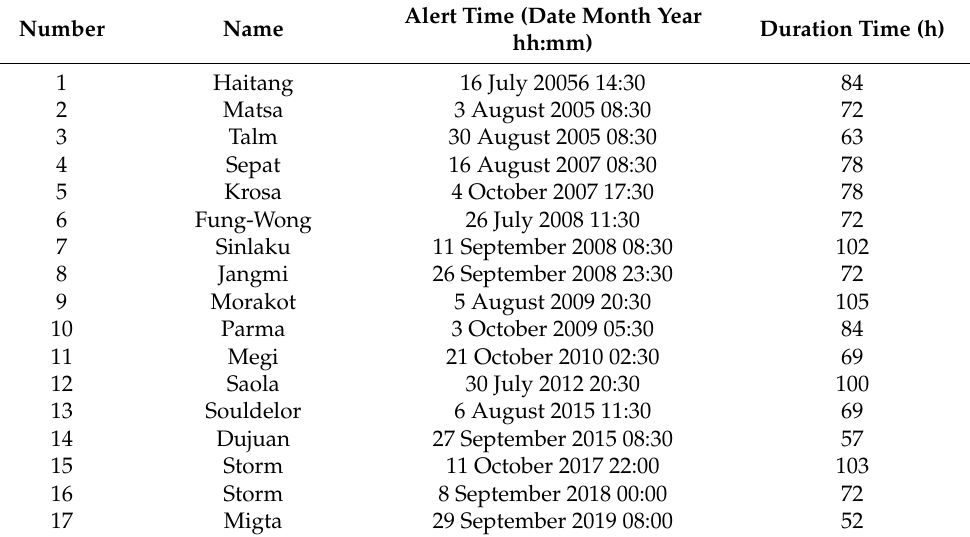
Table 1. Description of typhoons and storms used in this